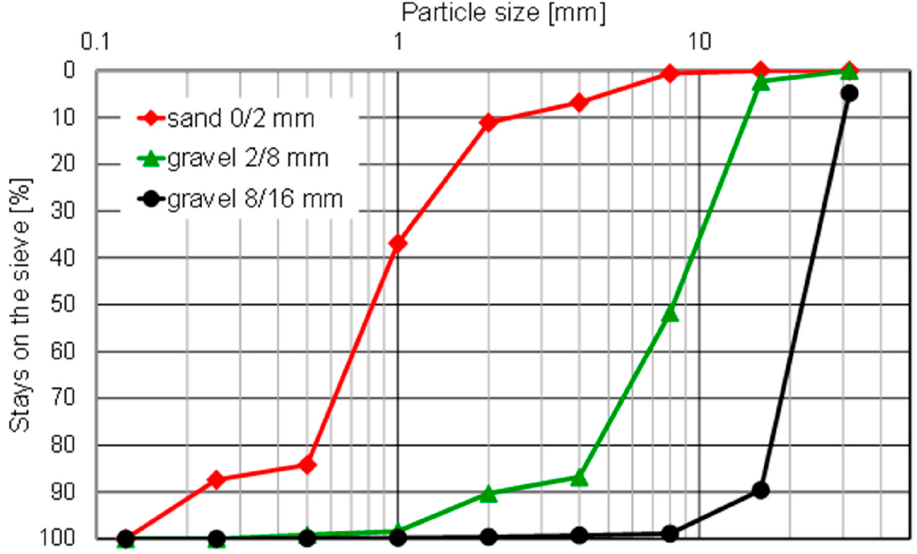
Figure 1. The grain size distribution curves of sand and gravel.